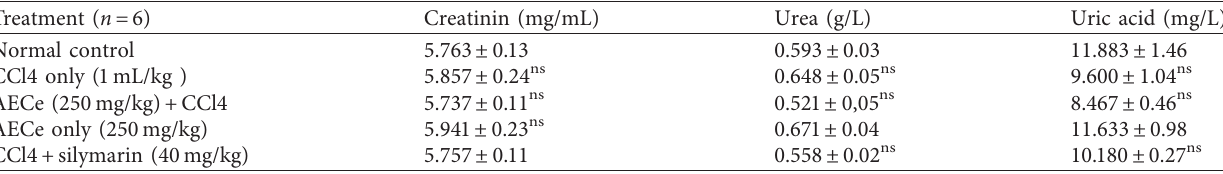
Values are expressed as mean ± SEM, ( n � 6). Data were analyzed by one-way ANOVA followed by Tukey’s test. ∗∗ p < 0 . 01 when compared to the normal control group; ∗∗∗ p < 0 . 001 when compared to the normal control group. ## p < 0 . 01 when compared to the CCl 4 group; ### p < 0 . 001 when compared to the CCl 4 group. Ns � not significant when compared to the CCl 4 +silymarin group. Table 3: Effect of aqueous extract of Caralluma europaea on CCl 4 -induced kidney function test in serum. Treatment ( n � 6) Normal